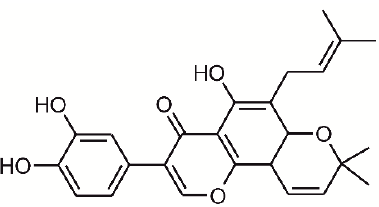
Figure 1. Structural formula of a naturally occurring prenylated flavonoid pomiferin, 3-(3,4-dihydroxyphenyl)-5-hydroxy-8,8-dimethyl-6-(3-methylbut-2-ene-1-yl)-4 H ,8 H -benzo[1,2- b :3, 5-hydroxy-8,8-dimethyl-6-(3-methylbut-2-ene-1-yl)-4 H ,8 H -benzo[1,2- b :3,4- b (cid:48) ] 4- b’ ]dipyran-4-one.